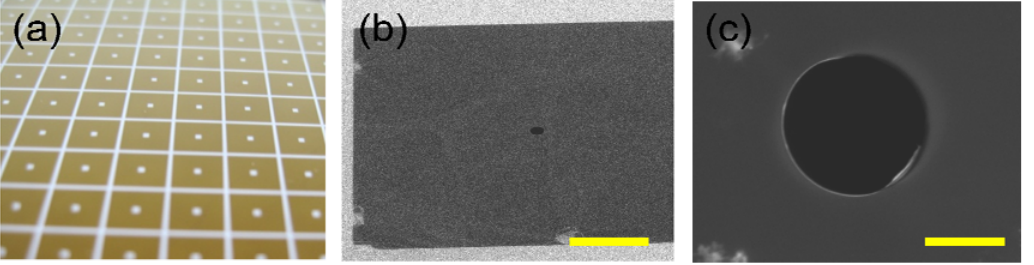
Figure 2. Micropore fabrication: (a) SiN wafer after photolithography and reactive ion etching processes, (b) SEM micrograph of free standing Si 1.25 µm diameter pore taken at 5k  , 3kV with 52.0  tilt using ion beam on DB 235 focused ion beam (FIB) and (c) up close micrograph of 10 µm diameter pore used in experimentation. The scale bars are 7 µm and 5 µm in (b) and (c), respectively.